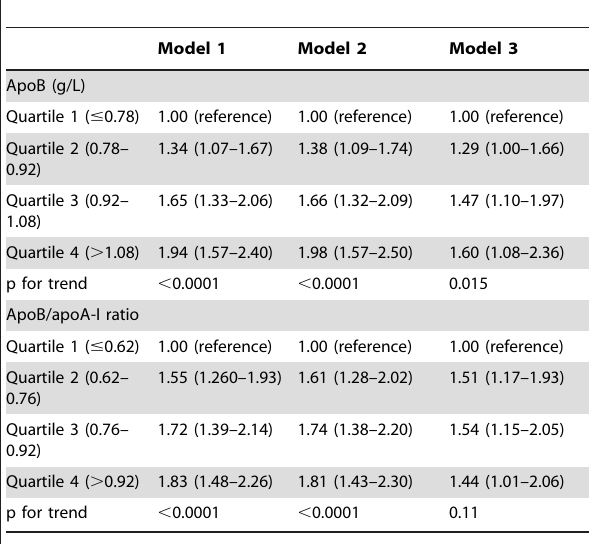
Table 4. The risk of elevated CIMT according to quartiles of serum apoB and the apoB/apoA-I